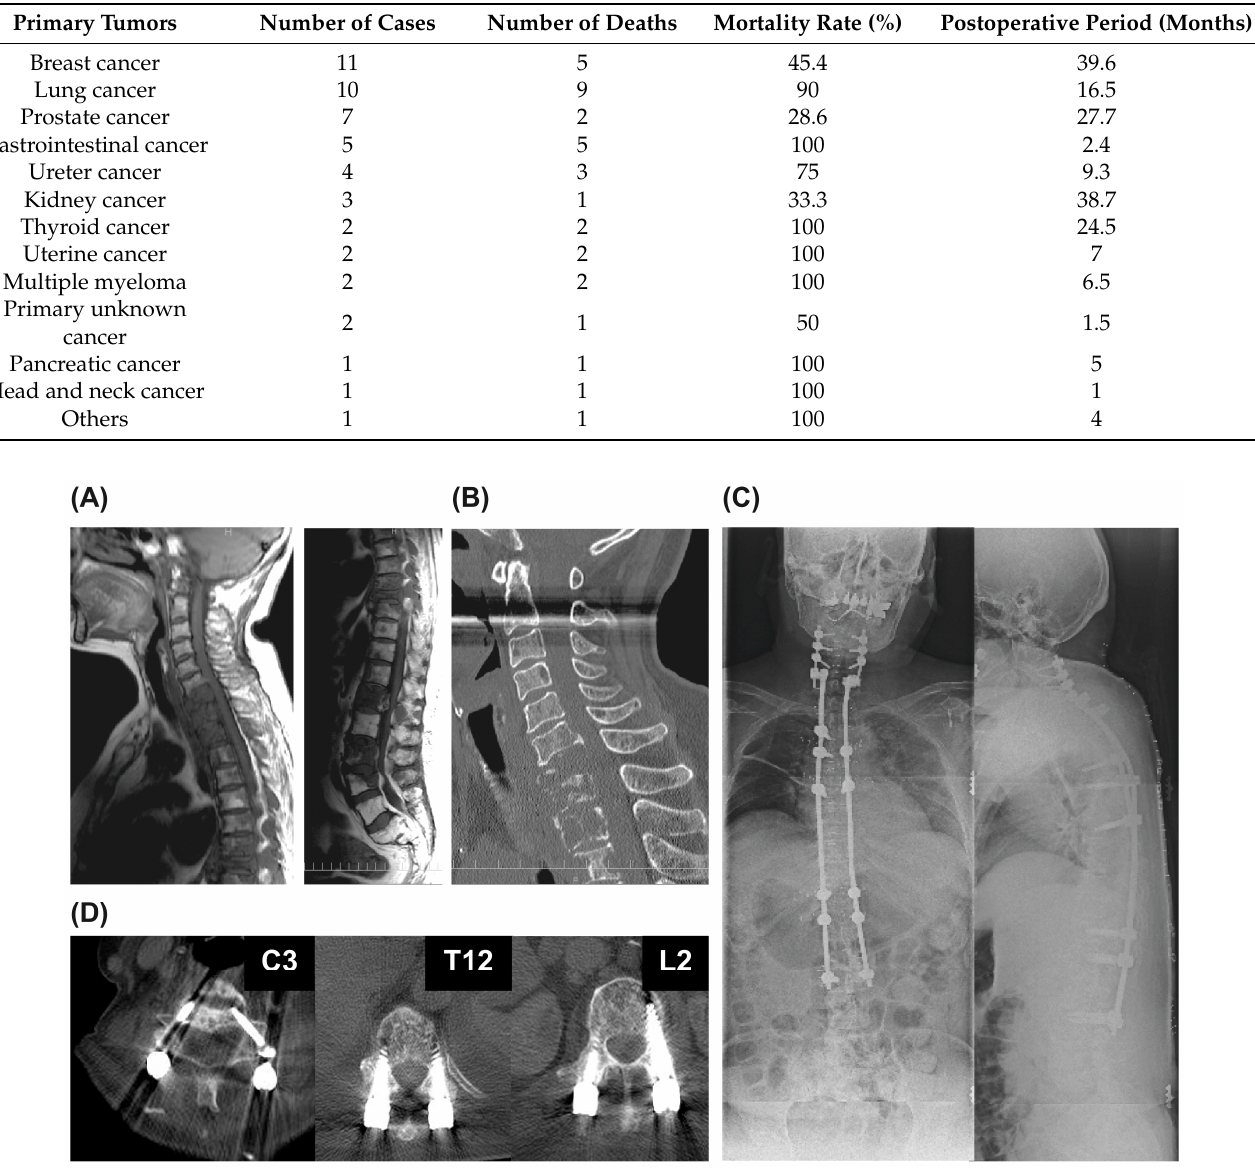
Figure 2. Case. A 63-year-old woman with metastatic spinal tumor of breast cancer. ( A ) Radiographs showing the first augmentation surgery. ( B ) Preoperative computed tomography (CT) image. ( C ) Radiograph showing the whole spine after surgery. ( D ) CT image at 43 months after surgery (C3, T12, L2 level).